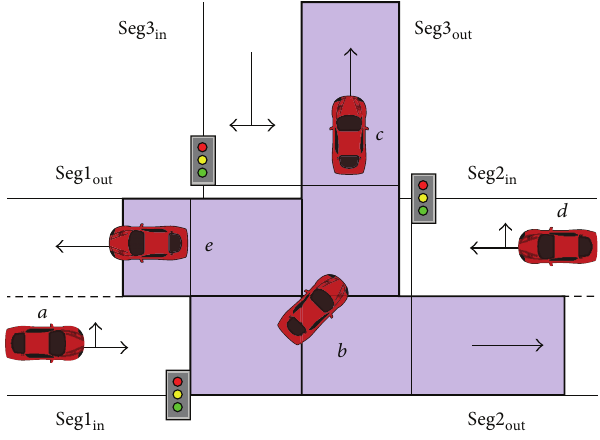
Figure 1: An example of a possible road traffic